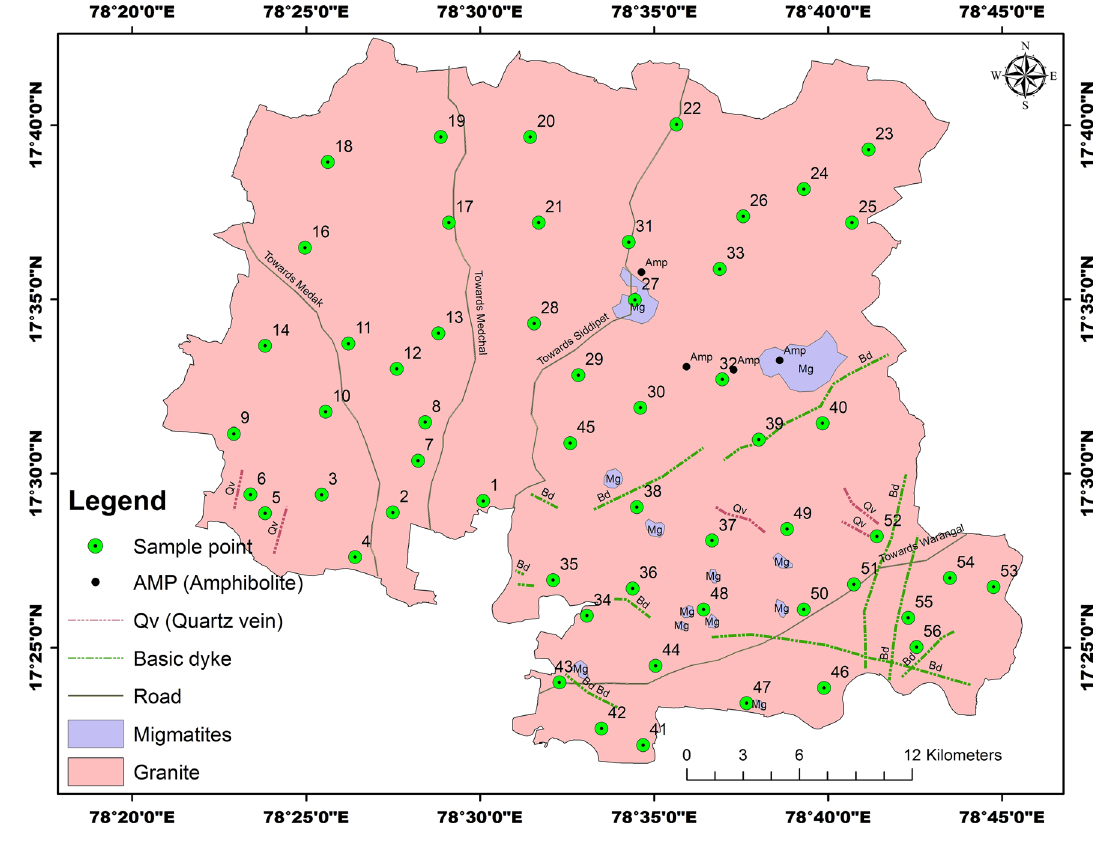
Fig. 4 Geology map of the study region showing sample